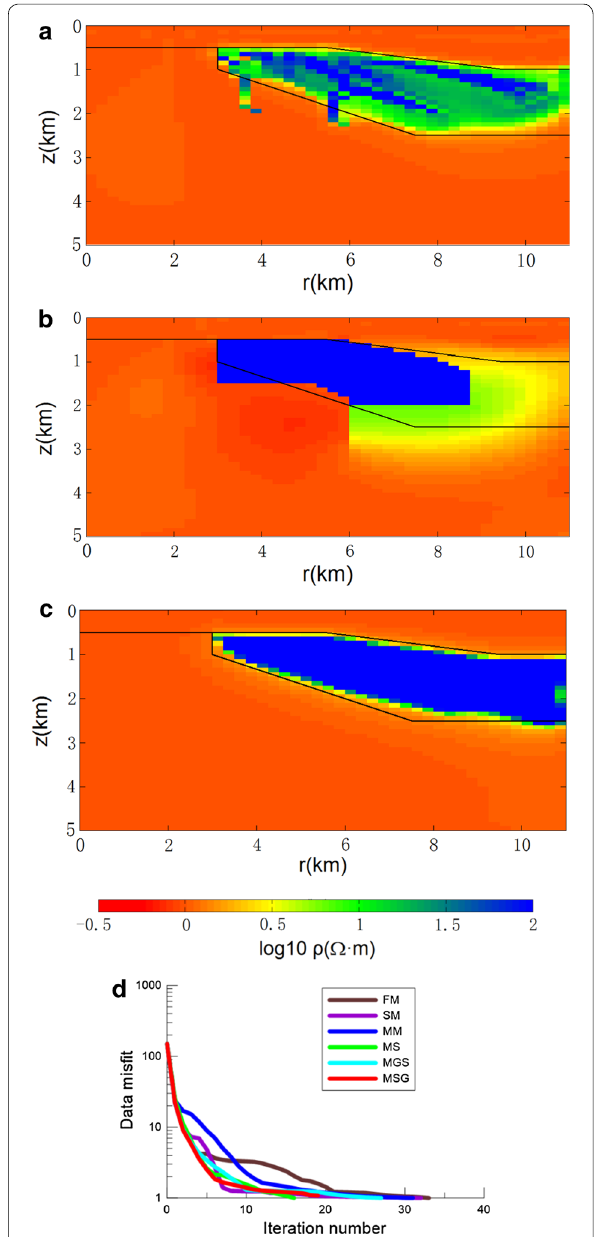
Fig. 12 Synthetic inversion results for the 2D resistive model (Fig. 6a) using different stabilizing functionals with β 2 0.001: a MS, b MGS, c MSG results, and d convergence of RMS data misfit. Color scale is =